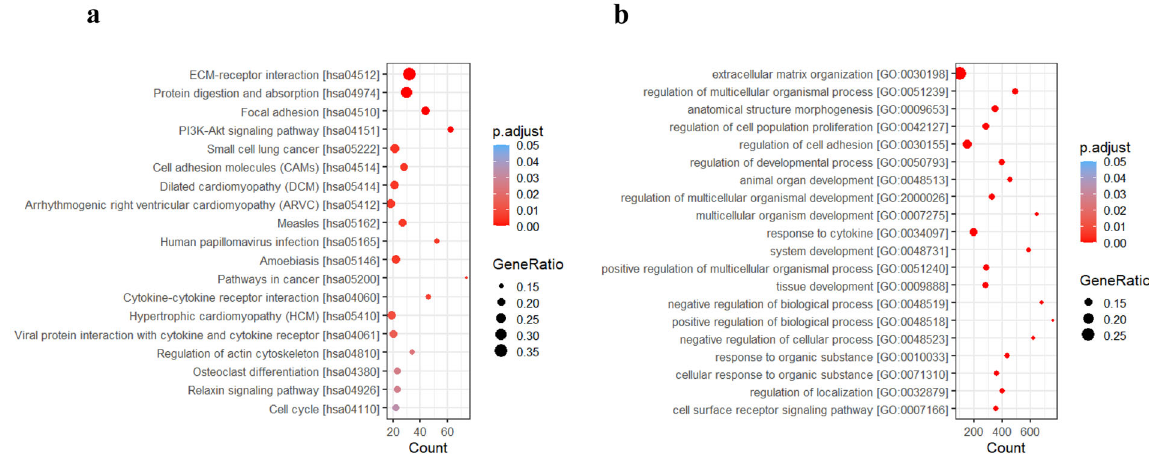
Fig. 3 Visualization of results of functional enrichment analysis of 1734 signi fi cantly differentially expressed genes in OSCC-GB patients. a The list of KEGG pathways ( n = 19) found signi fi cantly enriched. b Twenty most signi fi cantly enriched GO BP (biological process) terms. Both the lists are arranged from the top in ascending order of the p -value adjusted for multiple